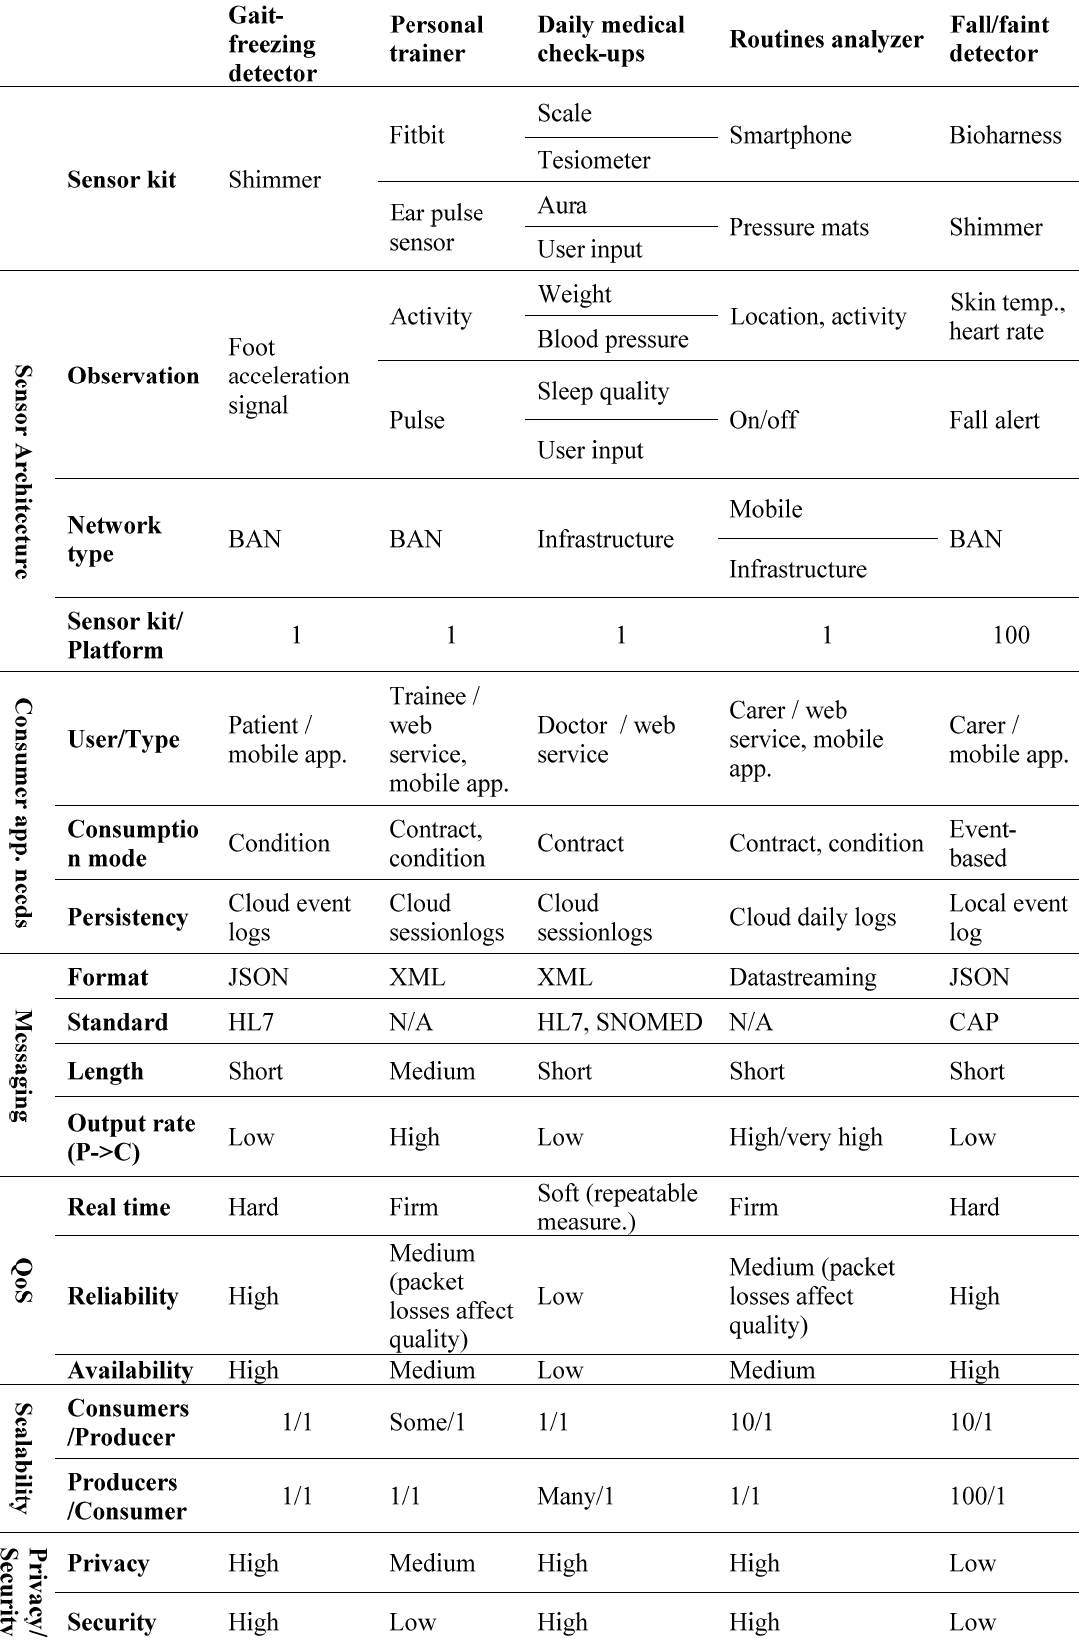
Table 2. Analyzing different service